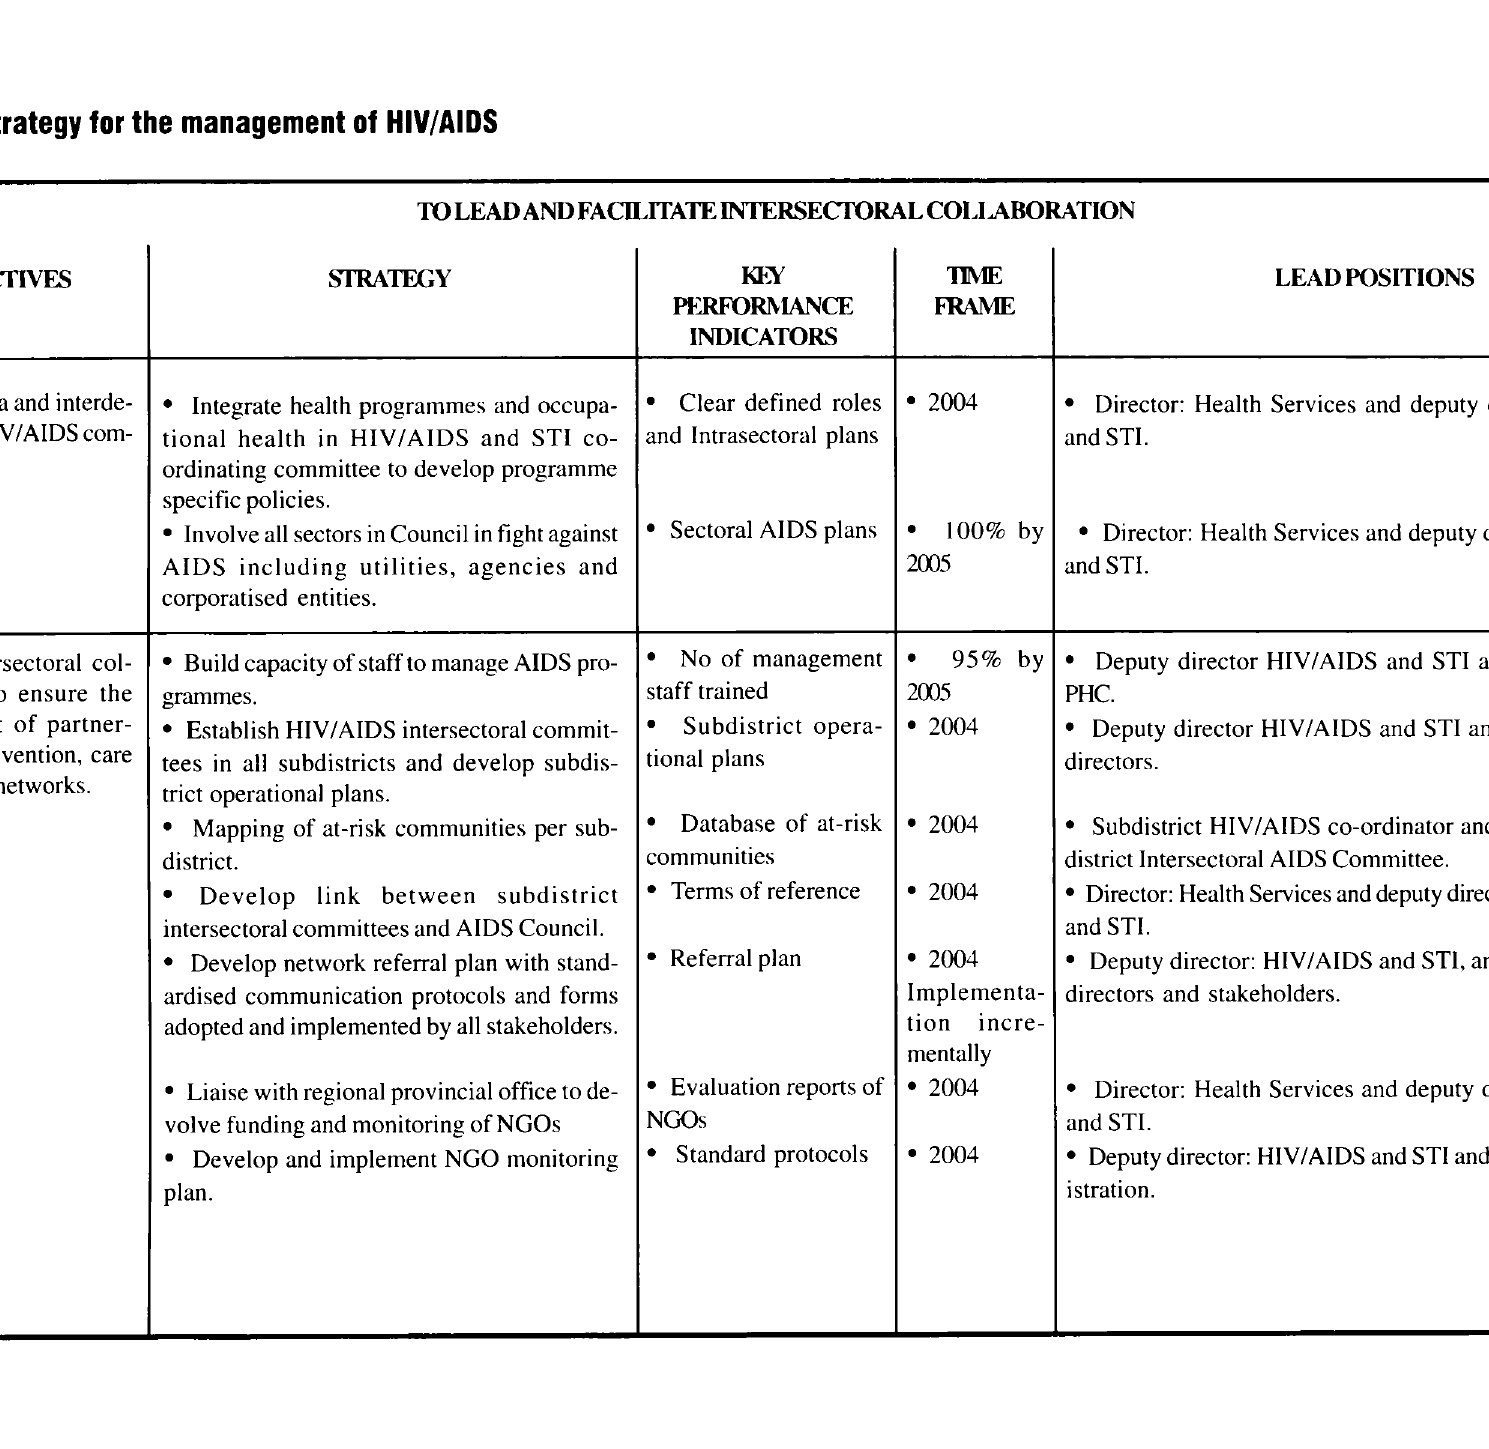
Figure 1 : Strategy for the management of HIV/AIDS TO LEAD AND FACILITATE INTERSECTORAL